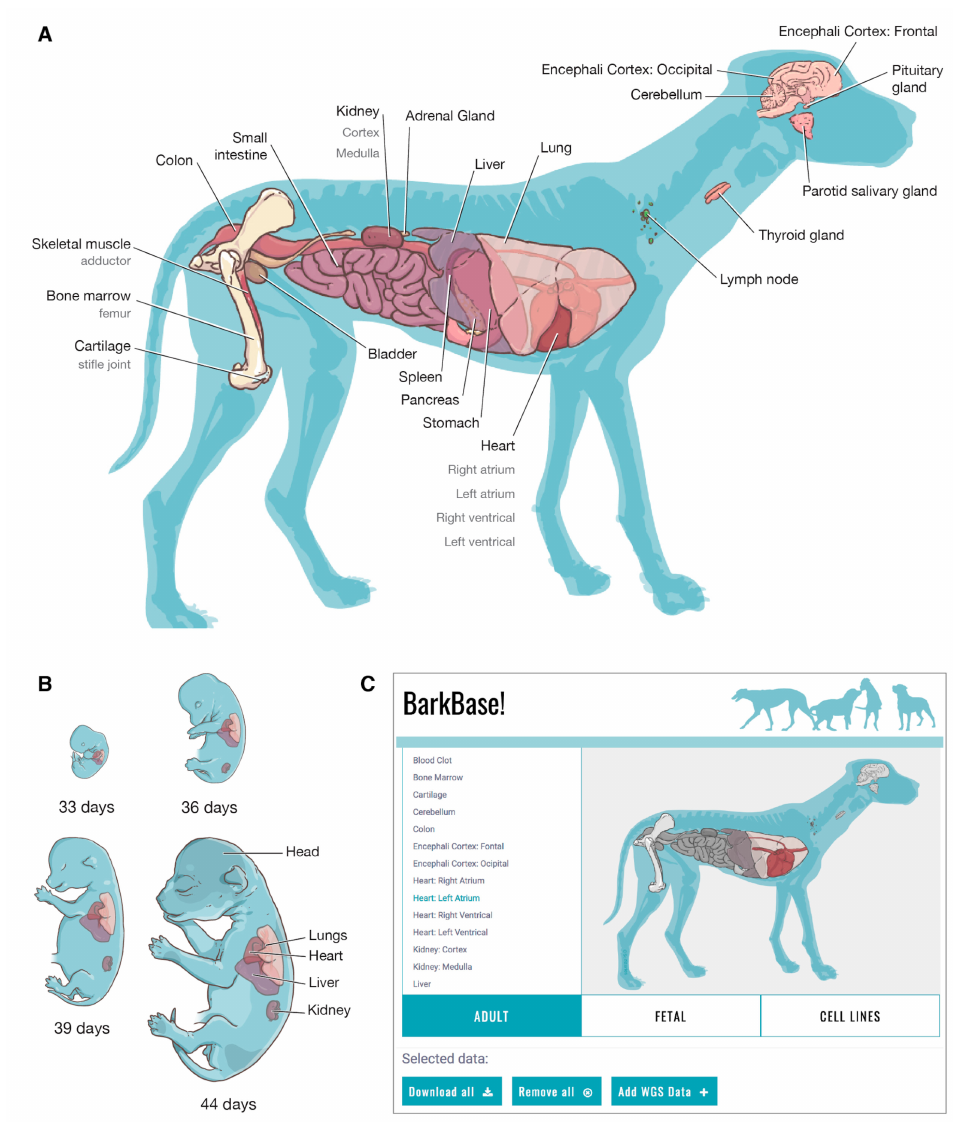
Figure 2. The BarkBase web portal. The BarkBase web portal enables download of whole genome sequence (WGS) data, RNA-seq data, and assay for transposase-accessible chromatin using sequencing (ATAC-seq) data for ( A ) up to 27 tissues from each of the five adult dogs; and ( B ) up to five tissues from canine embryos collected at each of the four staged gestational timepoints. Reads preprocessed and aligned to CanFam3.1 are available at BarkBase.org. From the BarkBase interface ( C ), users can readily select specific tissues and samples. Raw read data from RNA-seq and ATAC-seq is available through the Sequence Read Archive (SRA) (Table